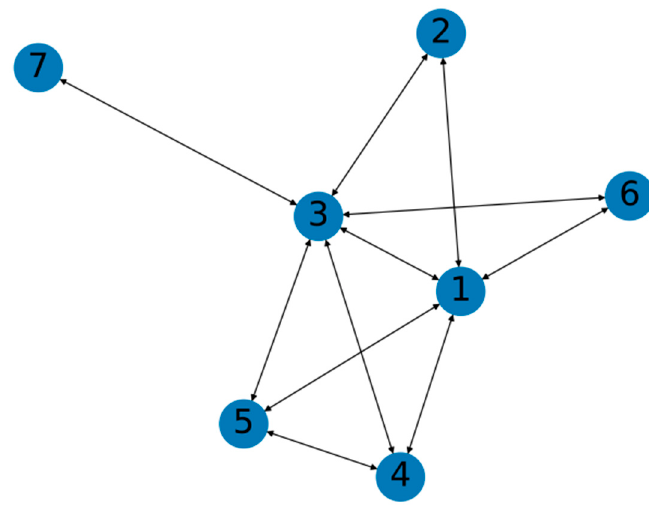
Figure 2. Air route graph between cities. Table 1. Fuzzy origin–destination.